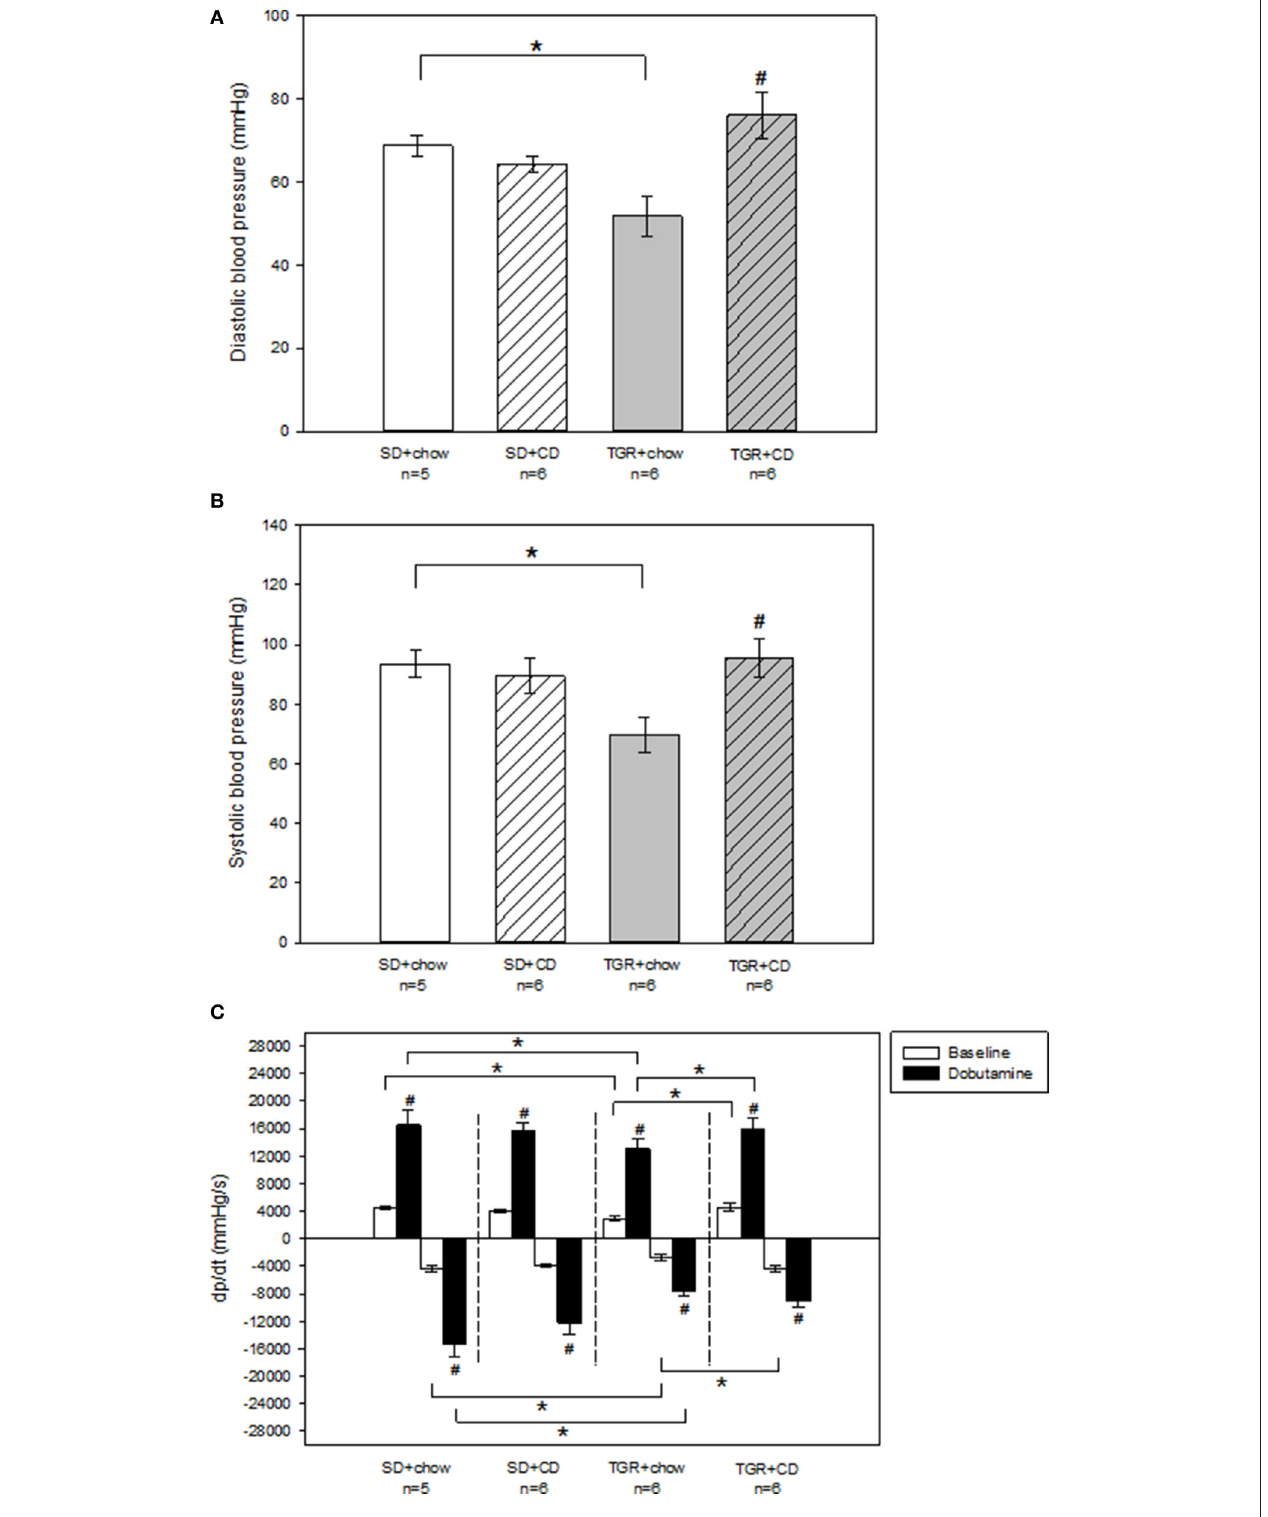
FIGURE 2 | Hemodynamic measurements of the left ventricle of male wild type Sprague Dawley rats (SD) and transgenic rats (TGR), overexpressing Ang(1-7) after a 5 month feeding period with either standard chow alone or simultaneously chow and cafeteria diet (CD). (A,B) Recordings of